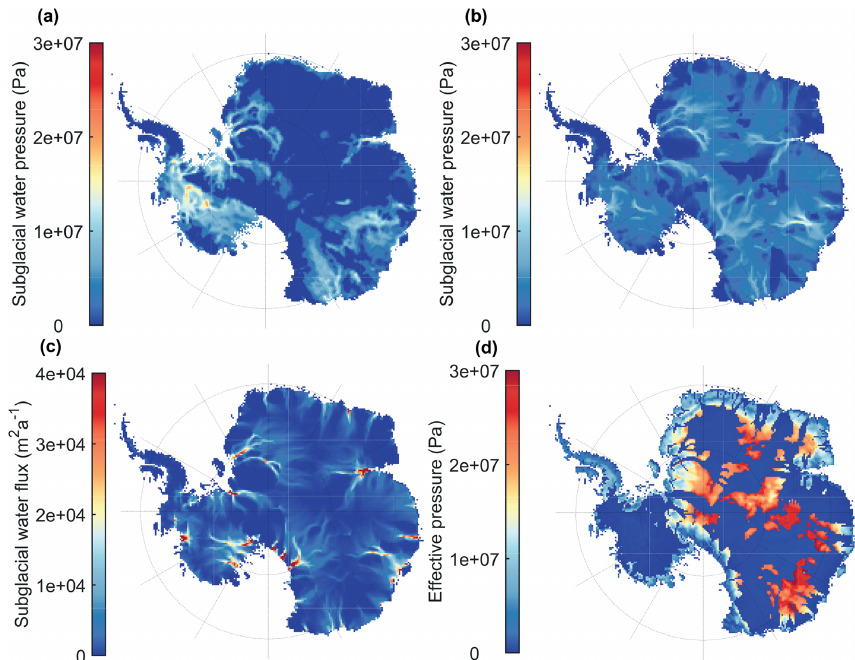
Figure 3. Steady-state subglacial characteristics for the Antarctic ice sheet according to the different subglacial models: (a) HAB subglacial water pressure (Pa); (b) SWD subglacial water pressure (Pa); (c) SWF subglacial water flux (m 2 a − 1 ); (d) TIL effective pressure (Pa).